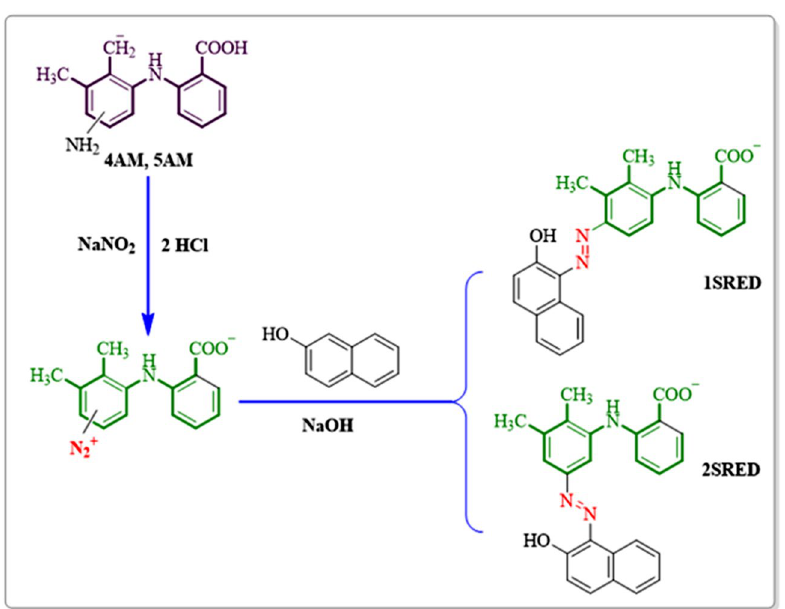
Figure 20. Diazotization and azo